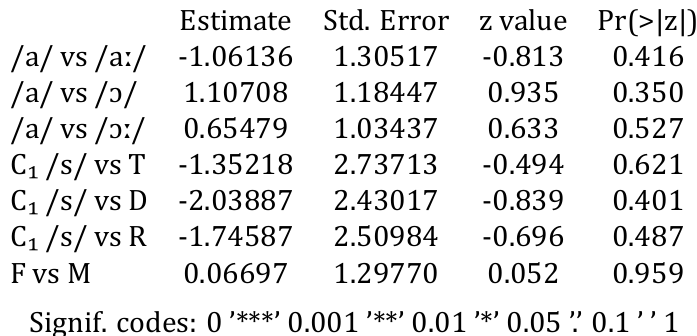
Table A.11: Post-aspiration occurrence of C₂ /s/ as a dependent variable